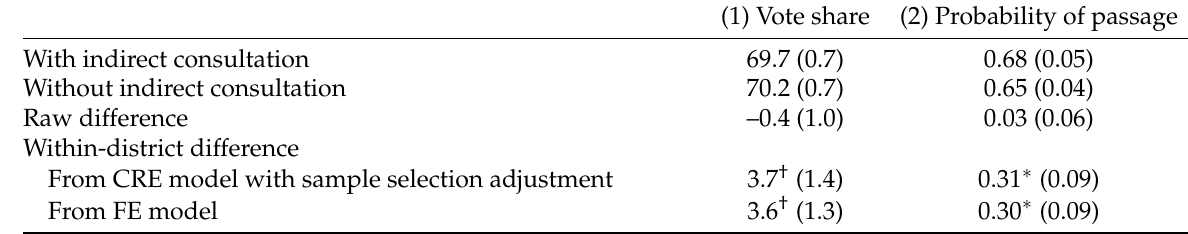
Table 1: Share of yes votes and passage as a function of indirect consultation in ballot measures for California school district parcel taxes,